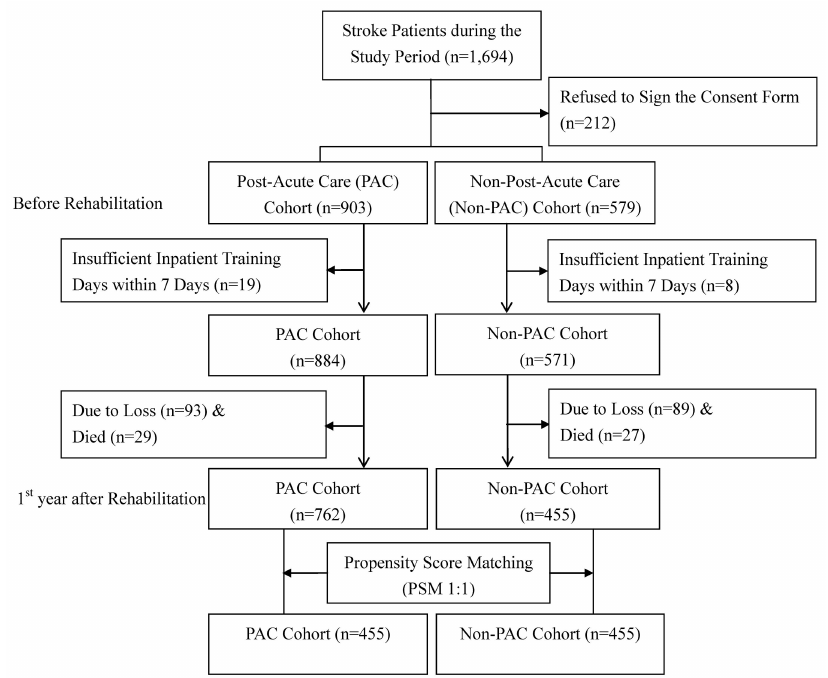
Figure 1. Flow chart of recruitment and study